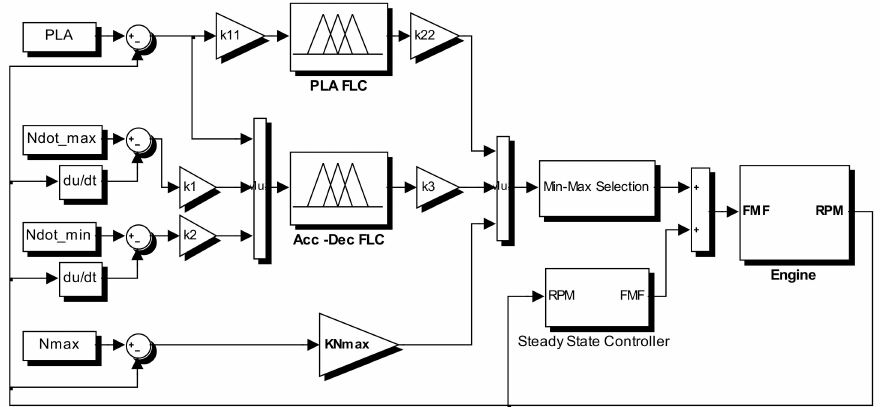
Figure 4. Min–max fuzzy controller (MMFC)